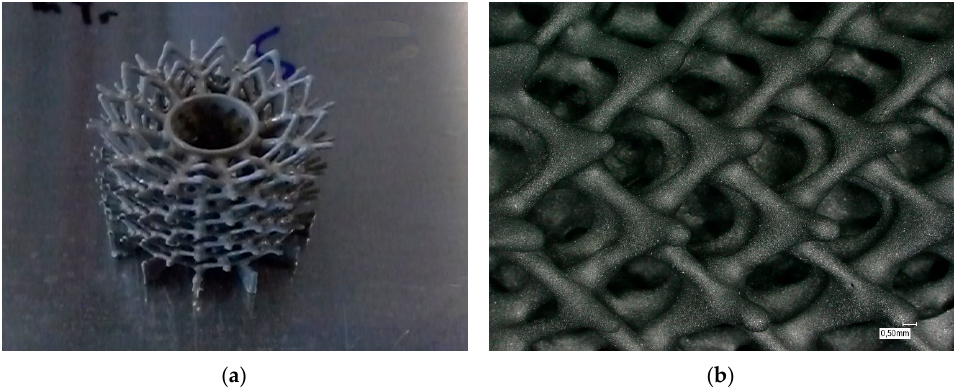
Figure 13. Replication of the polymeric template: polymeric template with dried ceramic coating before heat treatment ( a ) inner diameter of hole: 8 mm and ( b ) sintered SSiC struts.